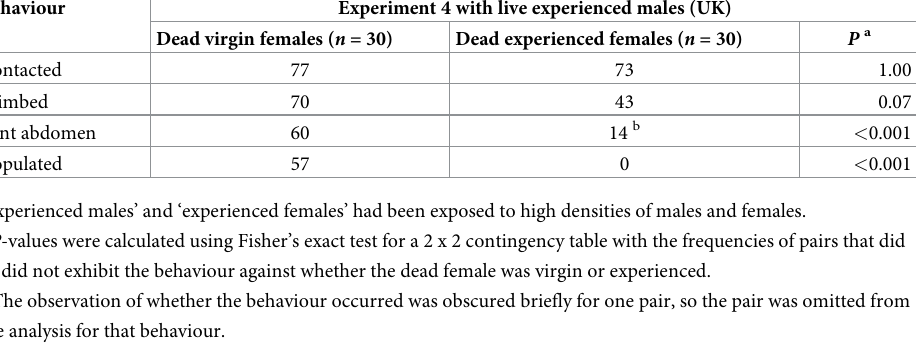
Table 3. The percentage of male-female pairs that exhibited each mating behaviour in the sequence of mating behaviours for live experienced males with either dead virgin females or dead experienced females. Behaviour